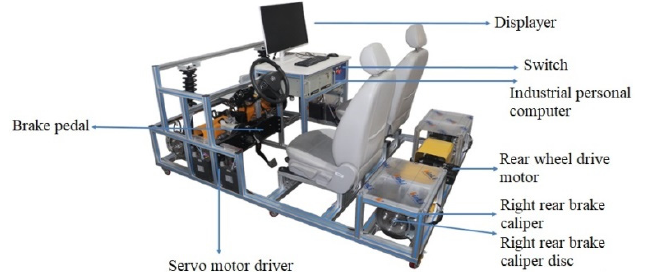
Figure 9. Matlab-Carsim HIL simulation platform.